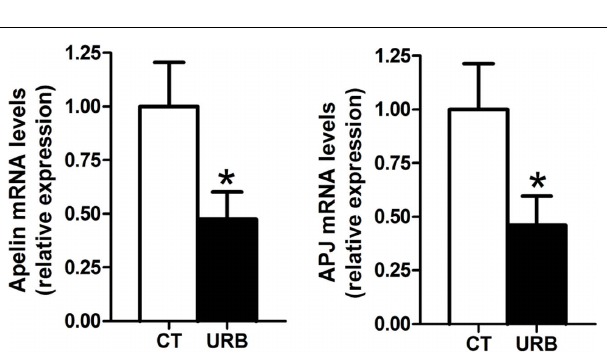
FIGUREA2 | FAAH inhibition decreasedApelin andAPJ mRNA expression in the adipose tissue of mice. Apelin and APJ mRNA expression measured in the adipose tissue of lean mice treated with a single dose of the FAAH inhibitor URB. Mean ± SEM, n = 6/group, * P < 0.05 determined by a two-tailed Student’s t -test.